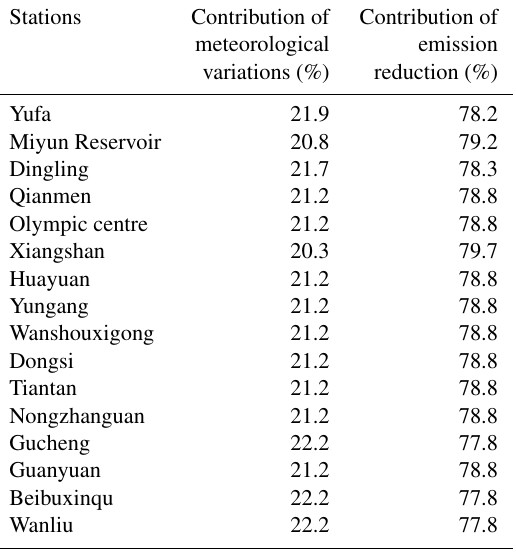
Table 6. Estimated relative contribution of emission reduction and meteorological variations to PM 2 . 5 reduction in Beijing from 2013 to 2017 using